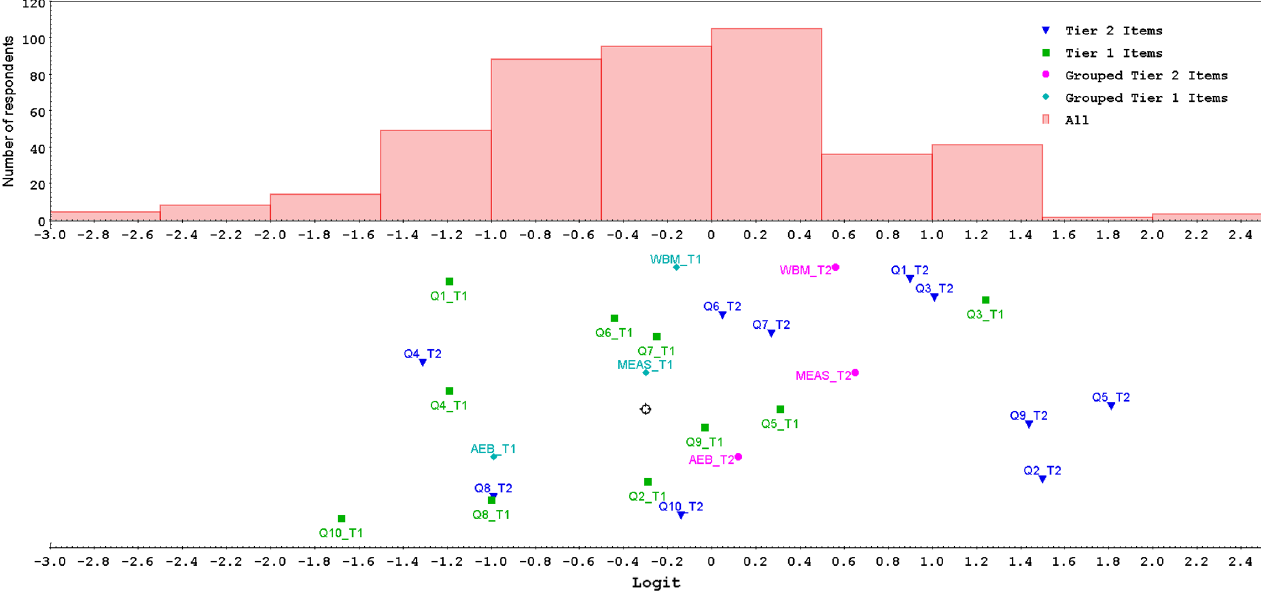
FIG. 2. Wright map of the QME. Items are grouped according to the three themes described in Sec. III. One extreme person (ability ¼ − 4 . 63 ) is